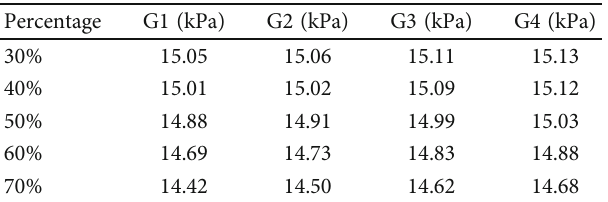
Table 3: Intraluminal pressure at the stenosis throat at the peak fl ow